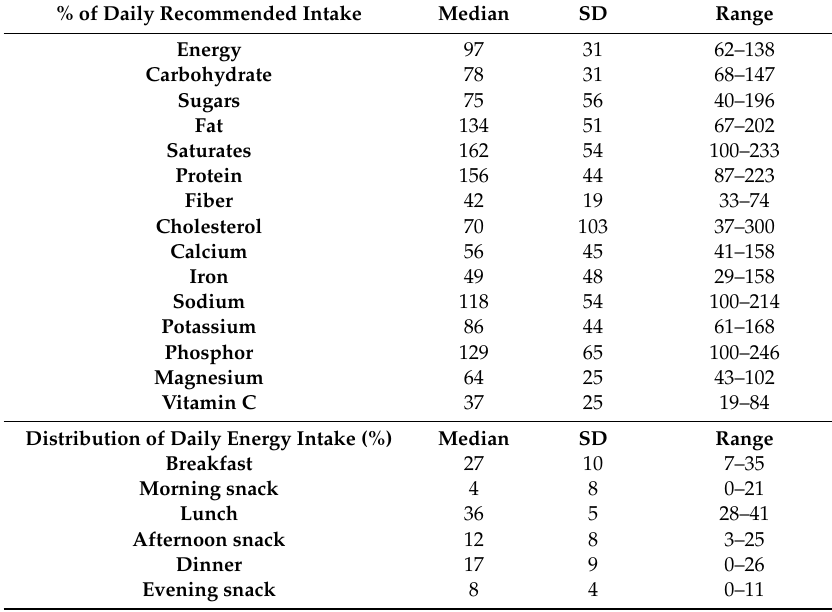
Table 2. Nutrition analysis results in % of daily recommended intake; done by using NutriPro Expert software (Note: Patients did not use any dietary supplements and / or vitamins and this data format was chosen in order to compare patients with each